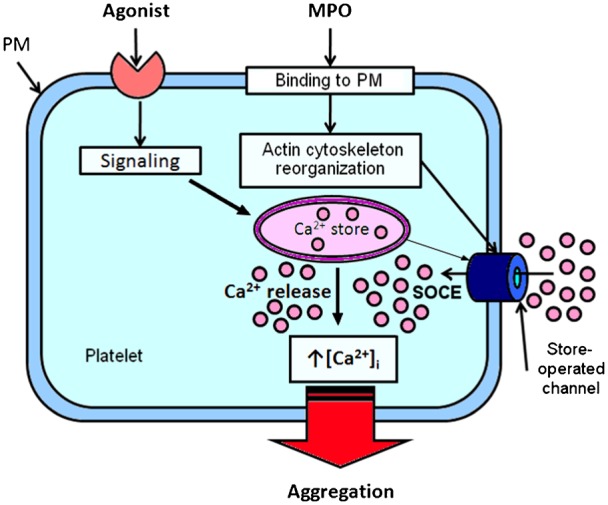
Schematic model depicting the role of MPO in regulating platelet activation.MPO binding to the platelet plasma membrane (PM) induces actin cytoskeleton reorganization that enables elevation in cytosolic Ca2+ concentration ([Ca2+]i) through enhancement of store-operated Ca2+ entry (SOCE) activated by depletion of intracellular Ca2+-store. An increase in [Ca2+]i triggers Ca2+-dependent signaling processes leading to the potentiation of agonist-induced platelet aggregation.